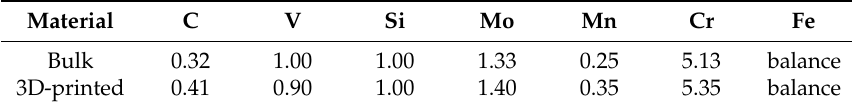
Table 1. Chemical composition of the bulk and 3D-printed AISI H13 tool steel in wt. %.